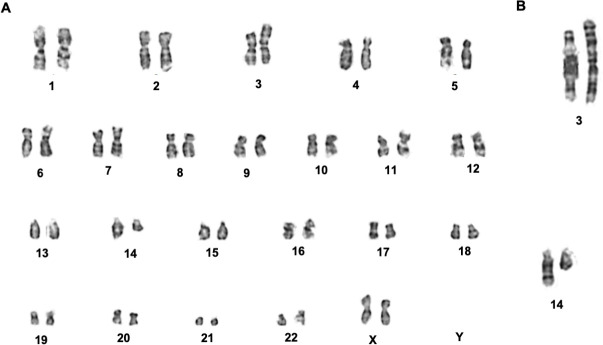
Karyotyping of VOA1066 cells.Analysis of 20 metaphases of VOA1066 cells revealed that VOA1066 cells have a stable diploid genome (A) with a translocation between chromosomes 3 and 14: 46,XX, t(3;14)(p25;q21) (B).